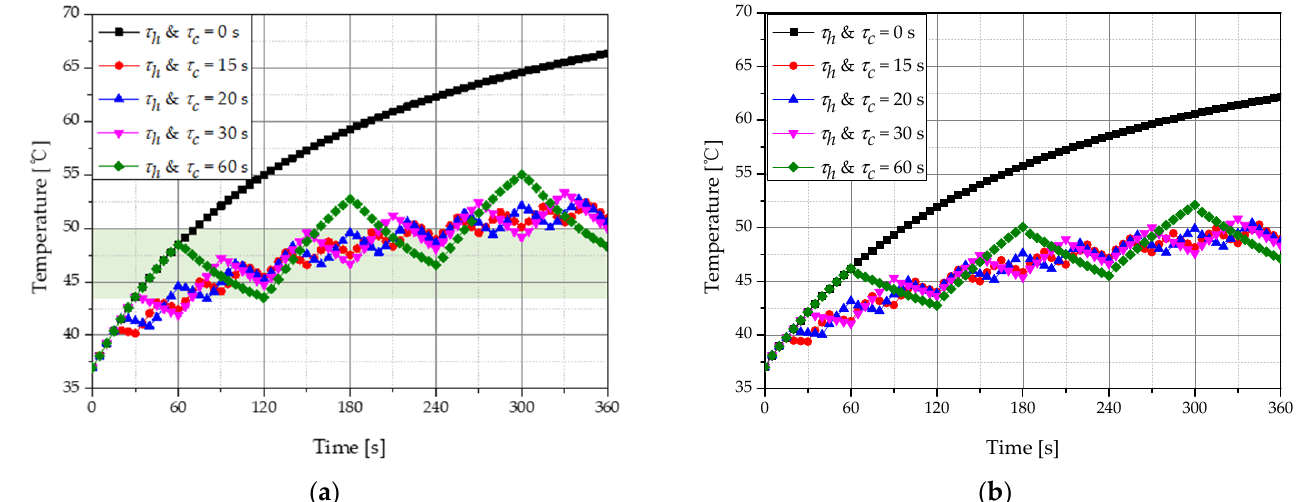
Figure 8. Temperature change for various heating and cooling time ( a ) tumor tissue (depth: 2 mm); ( b ) normal tissue (depth: 4 mm).